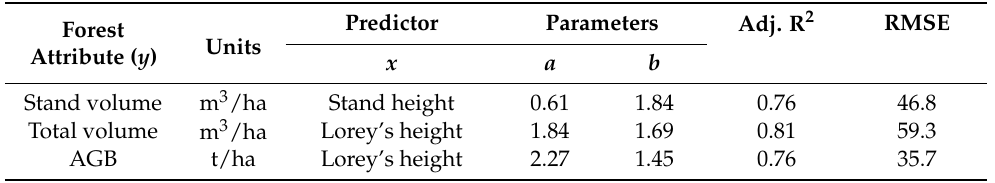
Table 4. Stand volume, total volume, and aboveground biomass (AGB) models, parameters, and goodness-of-fit metrics (adjusted (Adj.) R 2 , root mean square error (RMSE)) based on power function (y = a x b ) model form ( n = 211).